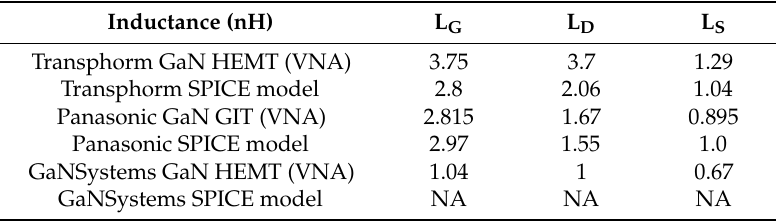
Table 3. Derived inductance values of gate, drain and source